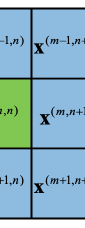
Figure 15. The representation of near-neighbor